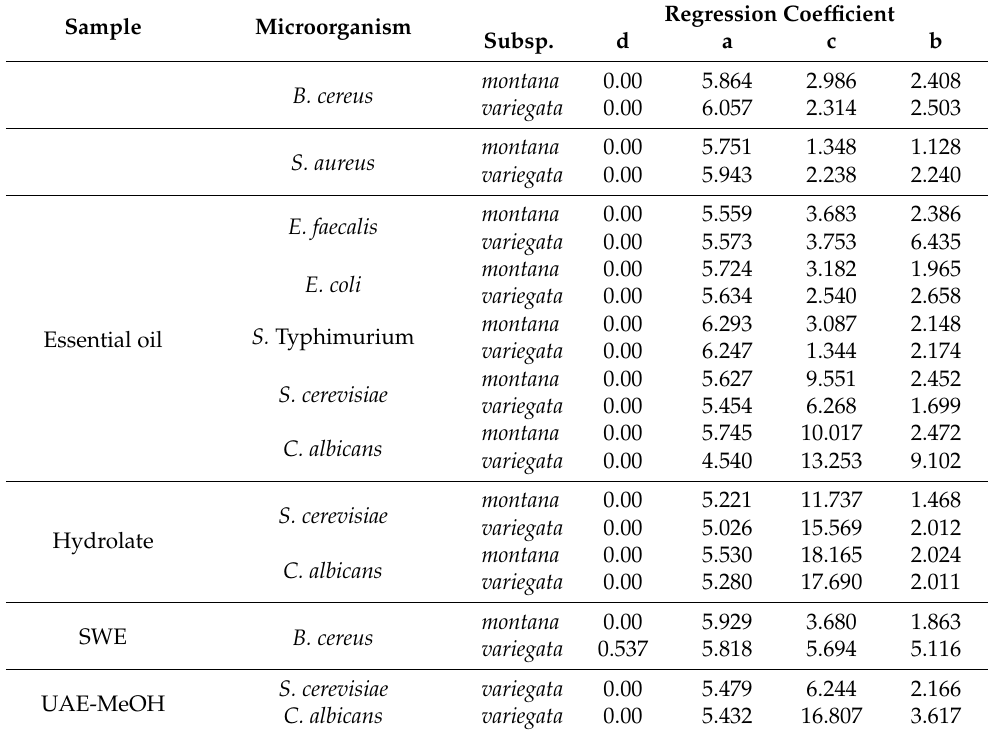
Table 3. The regression coefficients for kinetics modeling for pharmacodynamical potential of S. montana